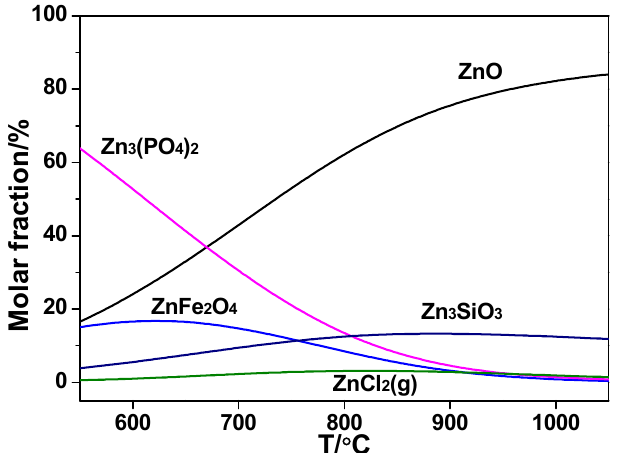
Figure 10. Effect of temperature on the distribution of Zn species in the co-combustion in thermodynamics.